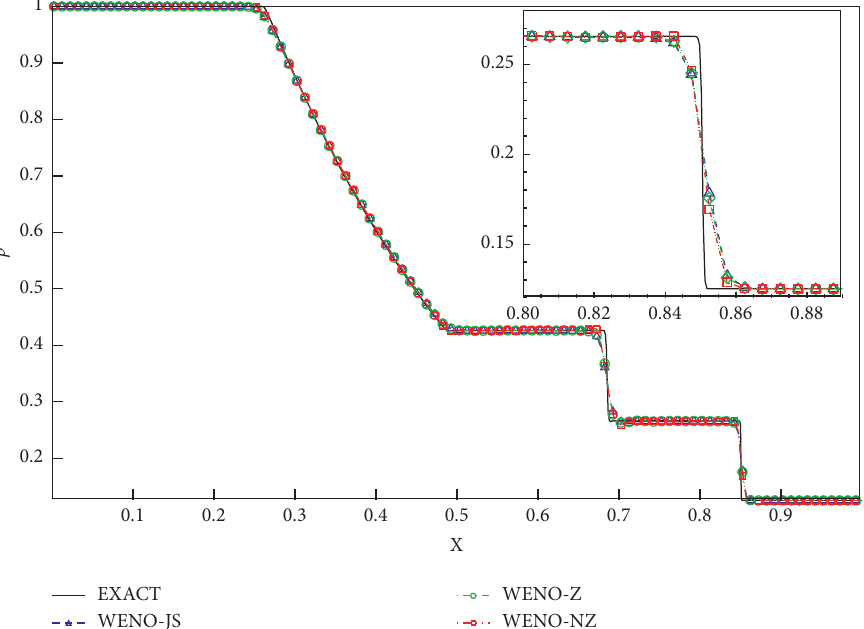
Figure 3: Density distribution of Sod’s problem at t � 2 computed by WENO-JS, WENO-Z, and WENO-NZ schemes with grids of N �